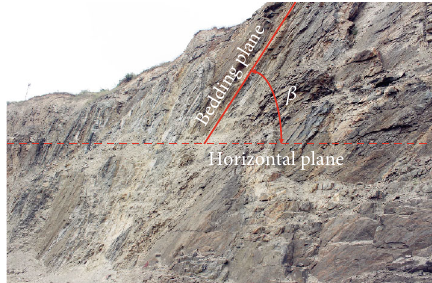
Figure 1: Diagram of layered rock